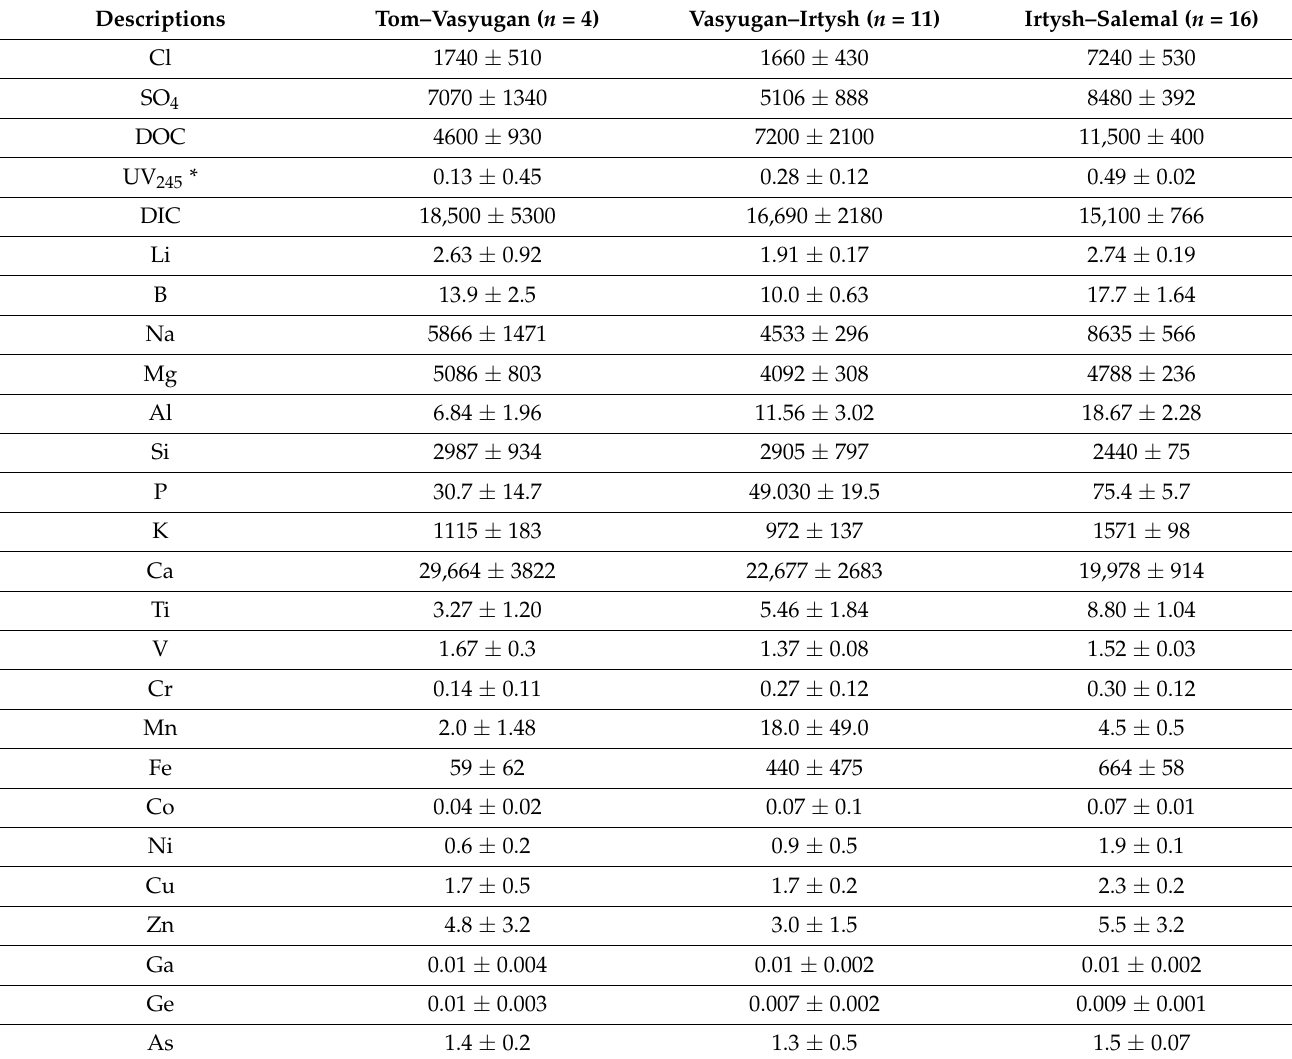
Table 1. Mean ( ± SD) concentration ( µ g L − 1 ) of major and trace elements in the three distinct parts of the Ob River main stem upstream and downstream of its confluence with Vasyugan and